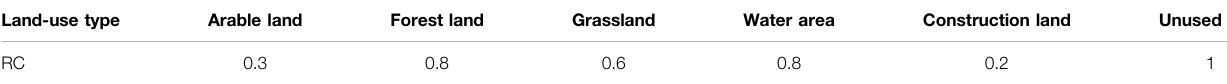
TABLE 5 | Coef fi cient of vitality for different land-use types.